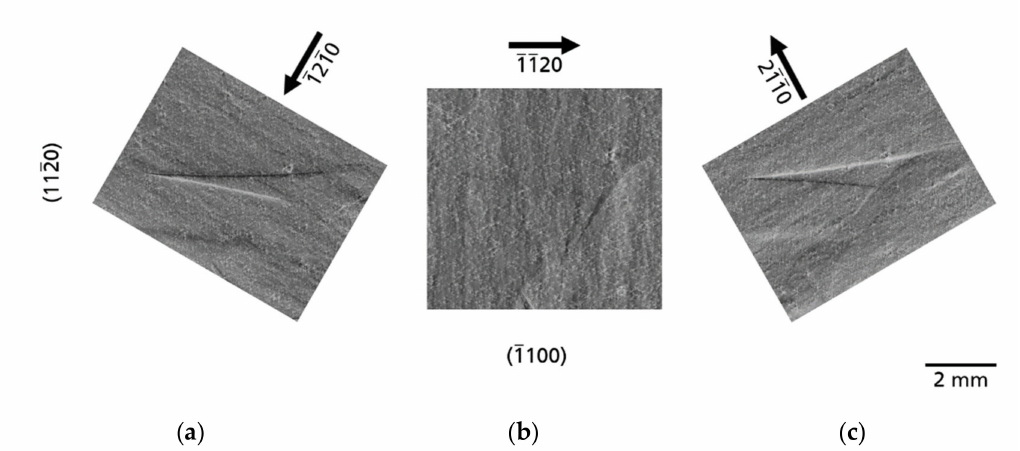
Figure 8. A planar defect caused by facet formation imaged with three different diffraction vectors (sample A); ( a ) reflection 1120, ( b ) reflection 1210 and ( c ) reflection 2110. While the defect is clearly visible in the 1210 and 2110 reflection topographs, it is almost extinct in the 1120 reflection